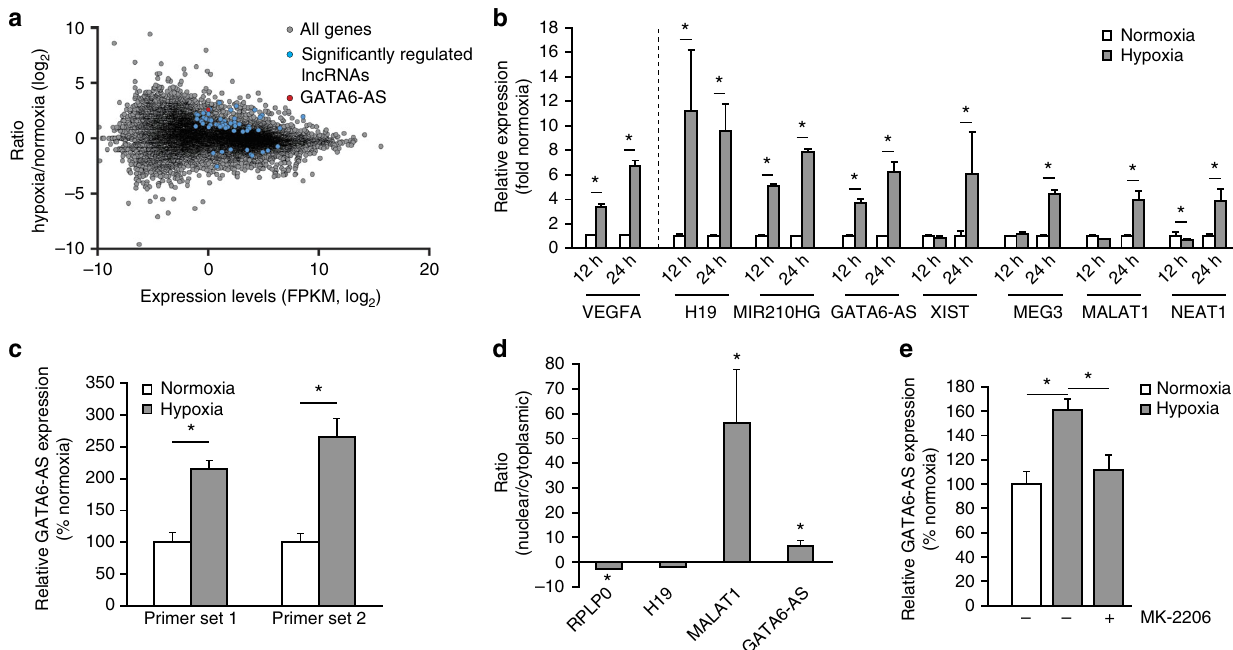
Fig. 1 The lncRNA GATA6-AS is hypoxia-induced and nuclear enriched in endothelial cells. a , b HUVECs were exposed to hypoxia (0.2% O 2 ) for 12 and 24 h or kept under normoxic conditions and gene expression changes were assayed by deep sequencing of ribo-minus RNA. a Signi fi cantly regulated lncRNAs are highlighted in blue, GATA6-AS is highlighted in red ( n = 2; statistical signi fi cance was assessed by Cuffdiff). b FPKM values were used to identify signi fi cantly regulated lncRNAs. VEGFA is shown as hypoxia-induced positive control ( n = 2; SEM; *statistical signi fi cance was assessed by Cuffdiff). c HUVECs were exposed to hypoxia (0.2% O 2 ) for 24 h or kept under normoxic conditions and regulation of GATA6-AS was con fi rmed by RT-qPCR using two primer sets targeting different regions of GATA6-AS. Relative expression was normalized to RPLP0 mRNA ( n = 4; SEM; * t test p < 0.05). d RNA was isolated from nuclear and cytoplasmic fractions and analyzed by RT-qPCR using primers targeting the indicated transcripts ( n = 4; SEM; * t test p < 0.05). e Akt phosphorylation was inhibited in HUVECs by addition of MK-2206 to the culture medium 1 h prior to hypoxic treatment (24 h, 0.2% O 2 ). As controls, cells were incubated under normoxic conditions. Expression levels of GATA6-AS were determined by RT-qPCR and normalized to RPLP0 mRNA ( n = 4; SEM; * t test p <